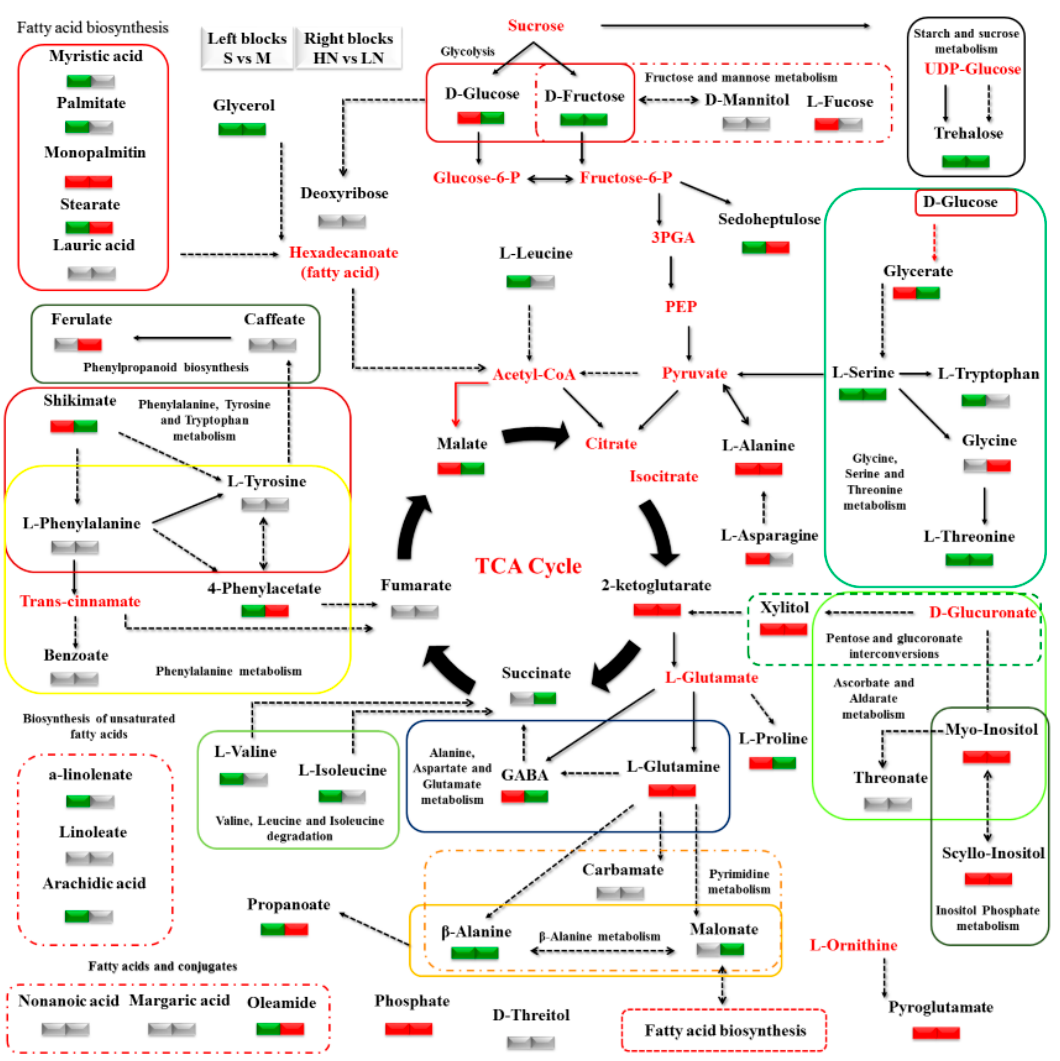
Figure 6. Fluctuation of Cichorium spinosum metabolite levels between the seaside (S) and montane (M) ecotypes (first block below metabolites) that were grown under low-N and 0.25 NH 4+ /total-N supply level and between plants of the montane ecotype grown in perlite bags. The figure also shows the impact of the two different total-N supply levels in the montane ecotype grown under medium ratio NH 4+ /total-N on its metabolic response (right block below metabolites). The metabolites in bold red font indicate the undetected metabolites. Red color corresponds to metabolites whose relative composition increased in the montane (M) ecotype or plants grown under low-N supply, whereas green applies to metabolites that decreased. Gray color blocks correspond to metabolites whose levels were not substantially altered (first block below metabolites). Data were retrieved from the KEGG database (http://www.genome.jp/kegg). Solid arrows correspond to subsequent steps of a biosynthetic pathway, whereas dashed arrows correspond to multi-step links. TCA: tricarboxylic acid cycle; PEP: phosphoenolpyruvate; GABA: γ -aminobutyric acid; UDP-Glucose: Uridine diphosphate glucose; 3PGA: 3-Phosphoglycerate.